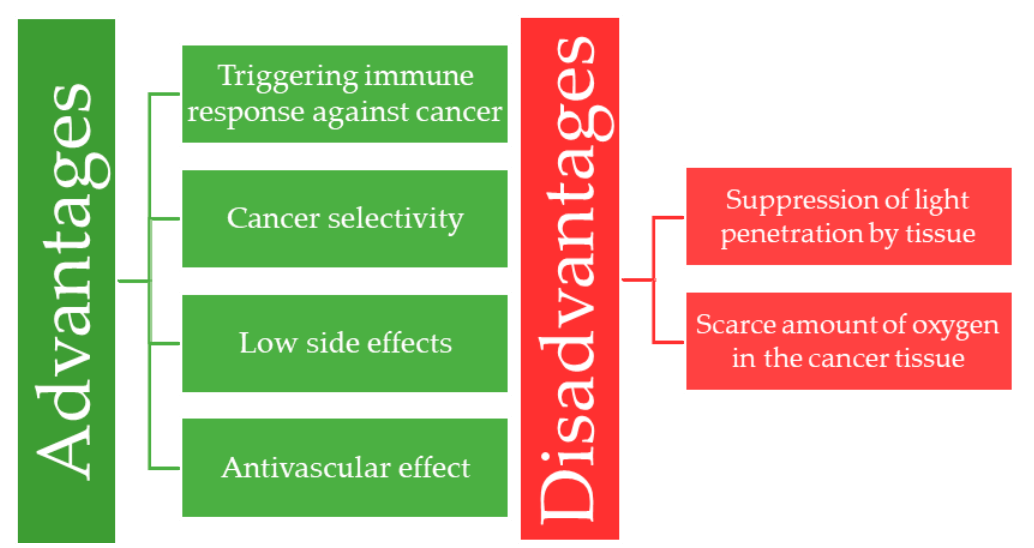
Figure 2. Summary of the main advantages and disadvantages of photodynamic therapy.